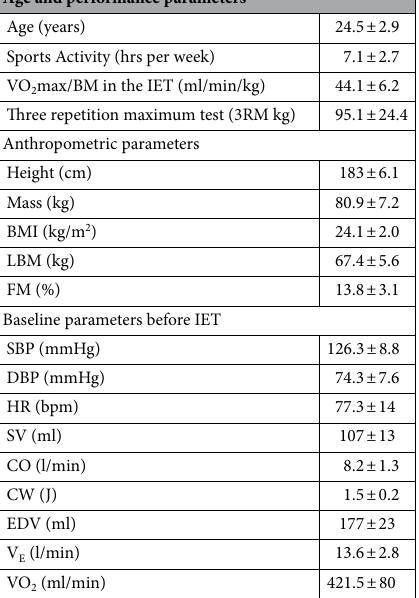
Table 1. Baseline characteristics of the study participants (n = 14). Values are presented as the means and standard deviation; BM body mass, BMI body mass index, LBM lean body mass, FM fat mass, IET incremental exertion test, SBP systolic blood pressure, DBP diastolic blood pressure, HR heart rate, SV stroke volume, CO cardiac output, V E ventilation, VO 2 oxygen uptake, CW cardiac work, EDV end diastolic